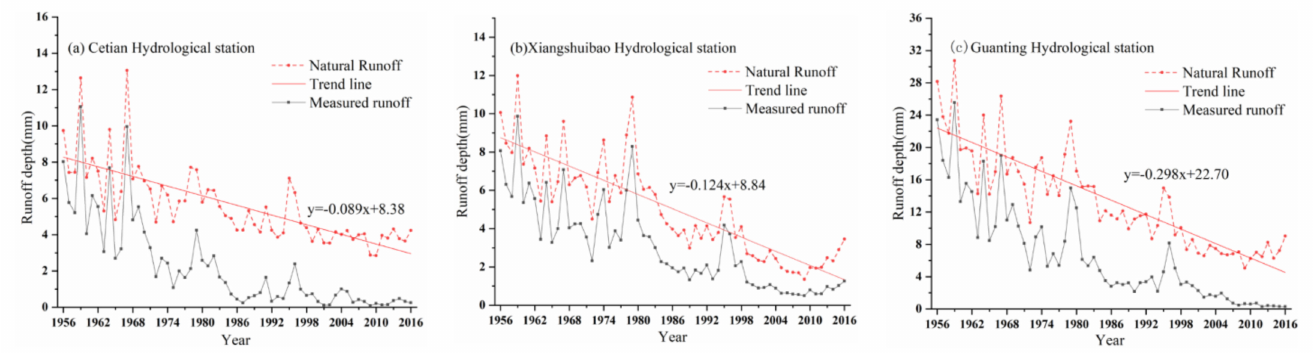
Figure 2. Annual natural runoff of the three hydrological stations in the mountain area of Yongding River from 1956 to 2016.